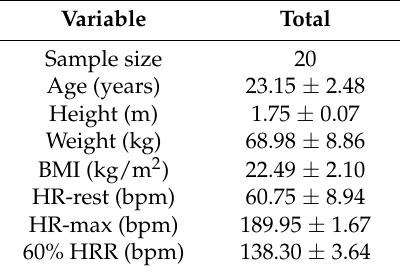
Table 1. Participants’ demographic